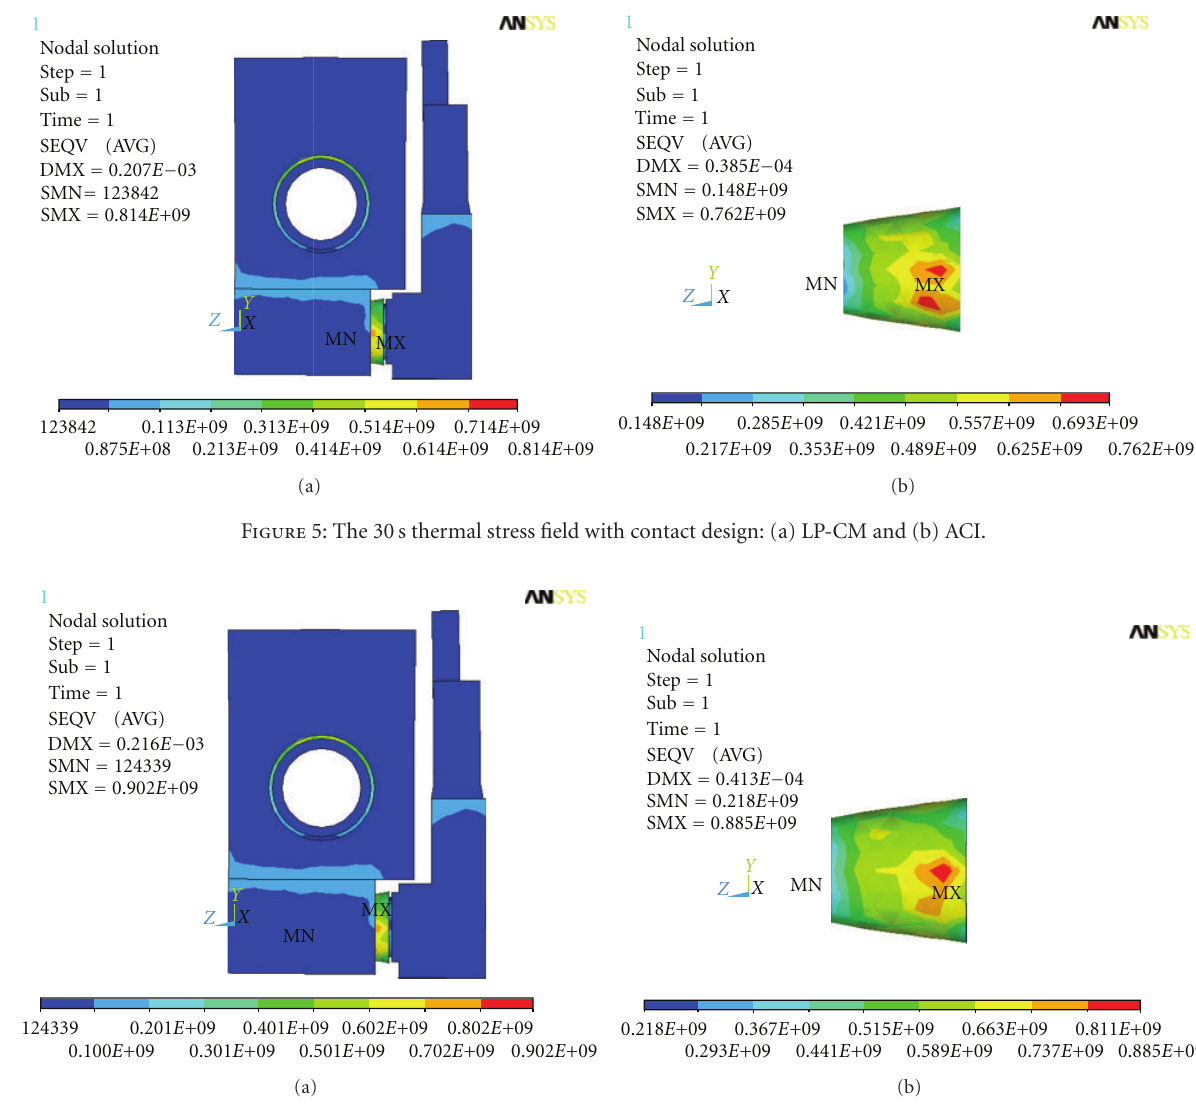
Figure 6: The 30s thermal stress field without contact design: (a) LP-CM and (b) ACI.